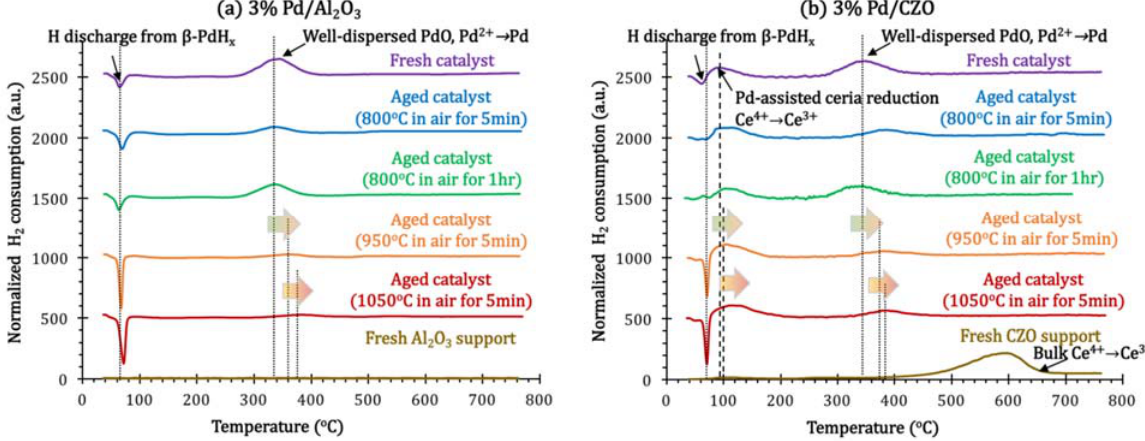
Figure 10. Normalized H 2 consumption in H 2 -Temperature Programmed Reduction (H 2 -TPR) measurements of fresh and aged ( a ) 3% Pd/Al 2 O 3 and ( b ) 3% Pd/CZO, as a function of reducing temperature. Aged samples for measurements were respectively achieved by aging the fresh ones in air at the following conditions: 800 °C for 5 min, 800 °C for 1 h, 950 °C for 5 min, or 1050 °C for 5